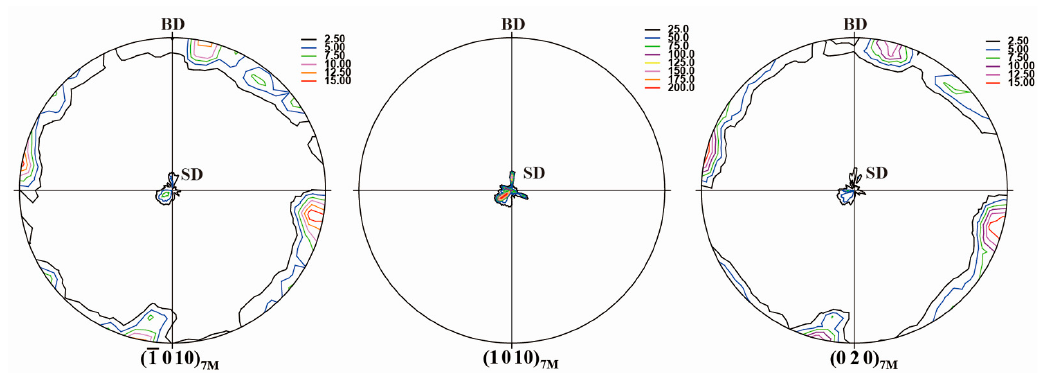
Figure 2. { − 1 0 10} 7M , {1 0 10} 7M and {0 2 0} 7M complete pole figures of 7M martensite measured from neutron diffraction for the directionally solidified Ni 50 Mn 30 Ga 20 alloy (BD: incoming beam direction; SD: solidification direction).